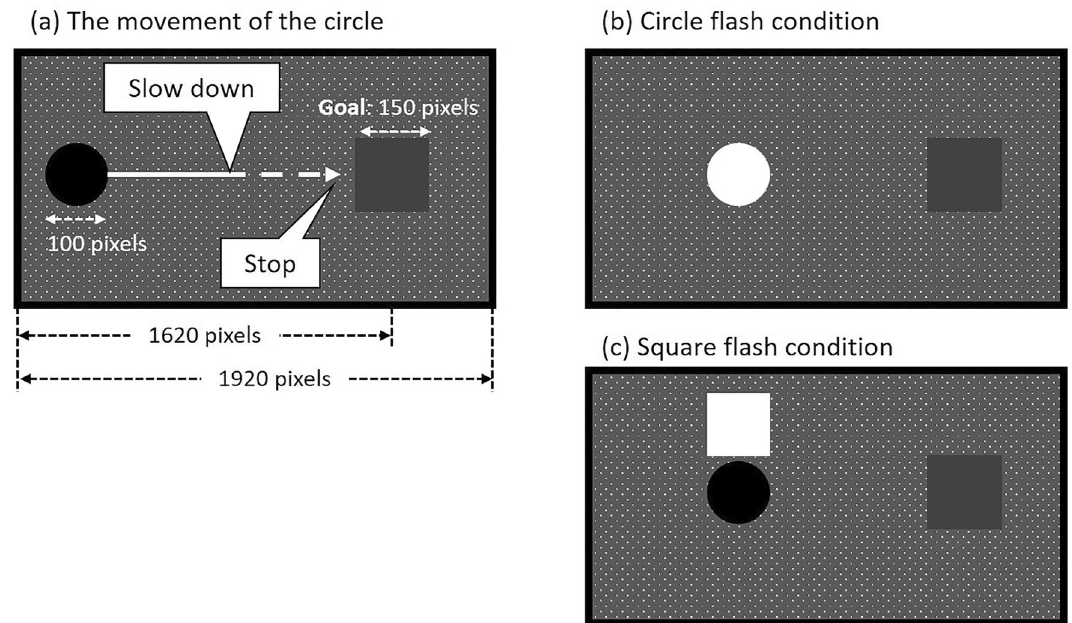
participants pressed the key in the action-contingent circle flash block, and at random in the random circle flash block. ( c ) The square flashing in Experiment 2 (for details, see Experiment 2). In Experiment 2, when participants pressed the key, the circle itself flashed or the white square appeared briefly above the